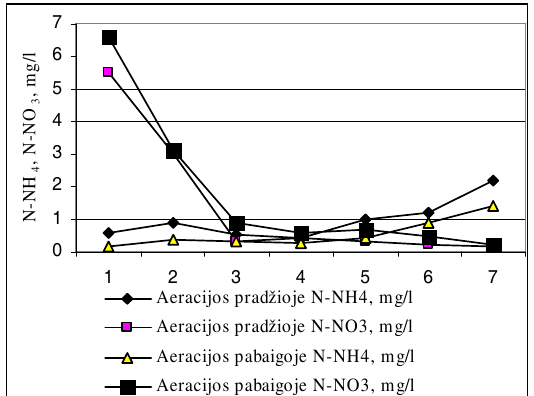
Fig 9. Concentration change of ammonium nitrogen and nitrates in the first aeration tank in the beginning and at the end of aeration at aeration rate of 120 min, and redu- ced aeration rate of 180